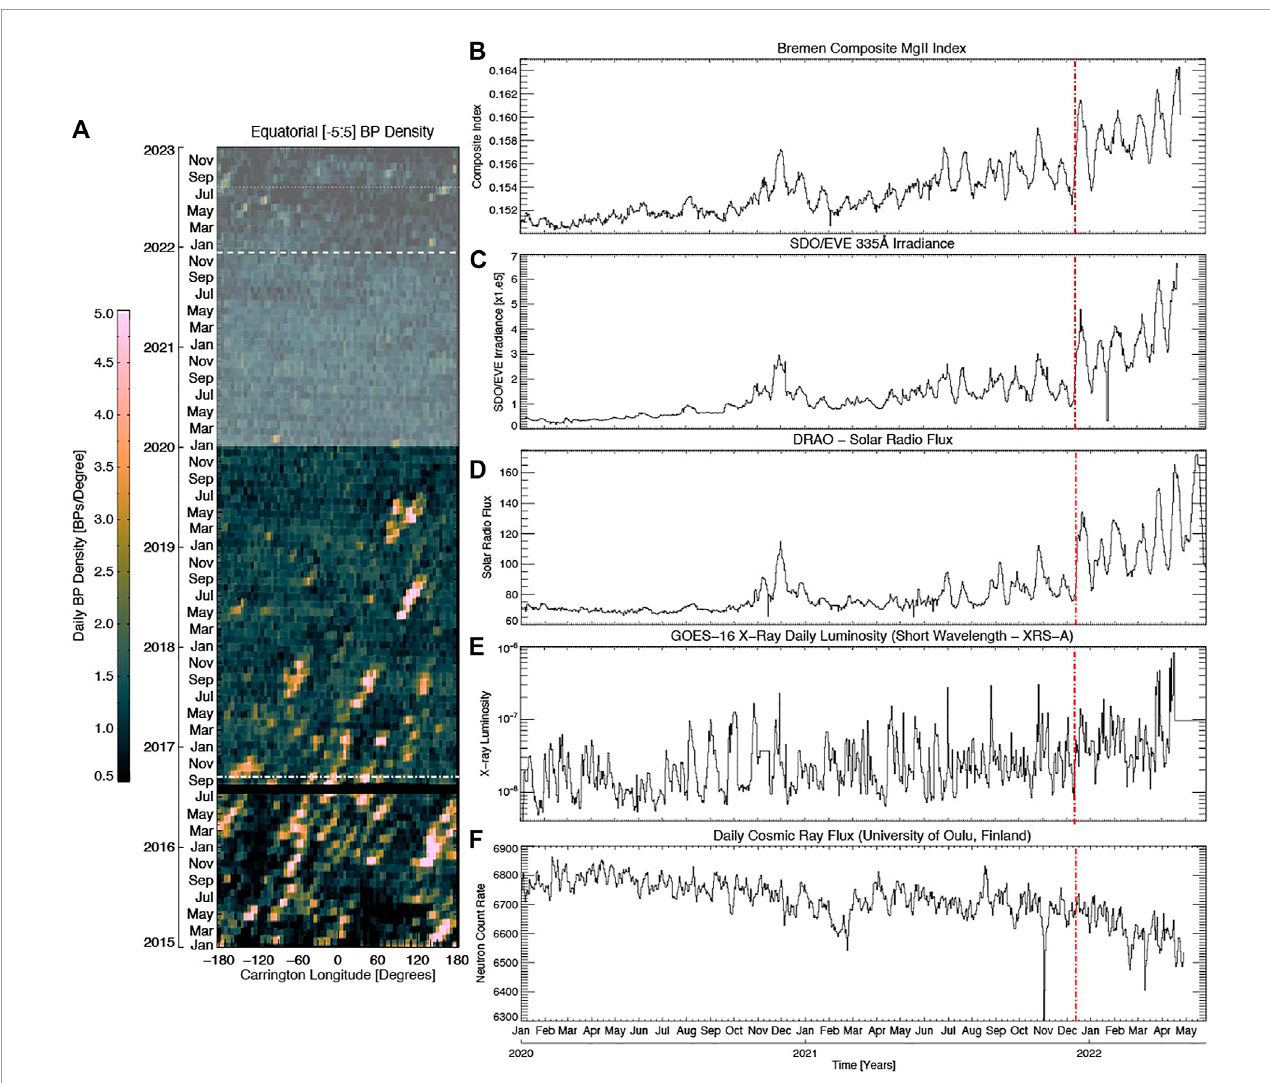
FIGURE 6 Hovmöller diagram of the SDO (AIA 193Å) EUV BPs since 2015 for the equatorial region (averaging −5°:5°). In panel A we shade the region from January 2020 to enable comparison with a range of full-disk solar proxies: the Bremen Mg II index (panel (B) ); the coronal SDO/EVE 335Å radiance (panel (C) ); the DRAO 10.7 cm radio flux (panel D ); the GOES-16 1-8Å X-Ray luminosity (panel E ); and the Oulu CRF (panel F ). In panels B–F the red vertical dashed line is placed at 13 December 2021.